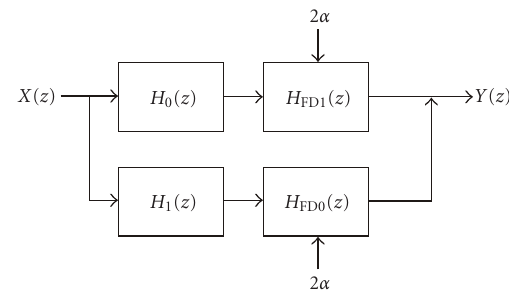
Figure 3: Resulting structure for FD filter.